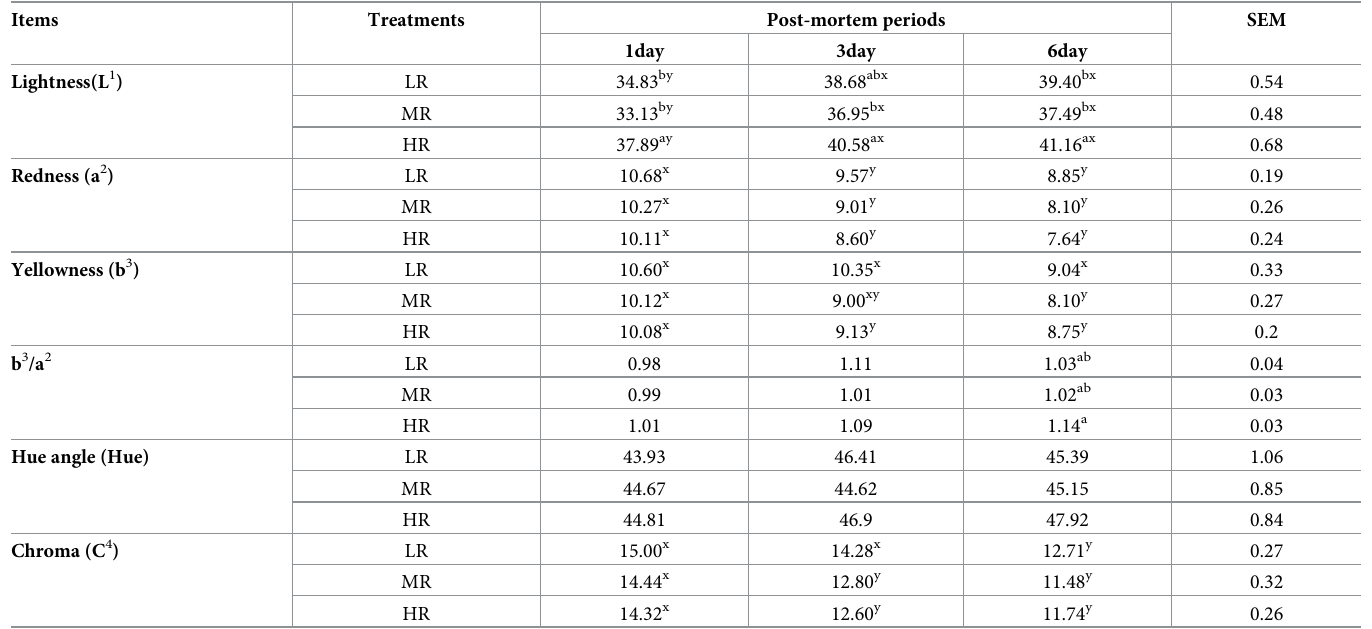
Table 5. Effect of dietary n -6: n -3PUFA ratios on meat color of longissimus dorsi during the post-mortem period in goats. Items